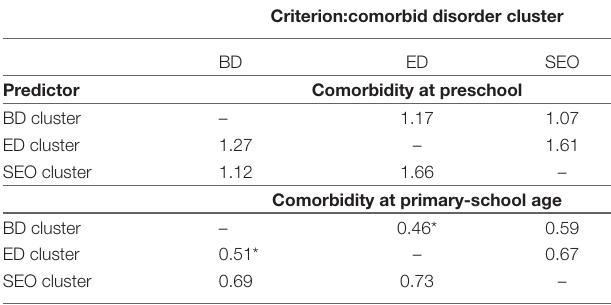
TABLE 2 | Odds ratios of comorbidities of BD (behavioral disorder), ED (emotional disorder), and SEO (specific early onset) disorder clusters (see text) at preschool age and primary-school age ( N =